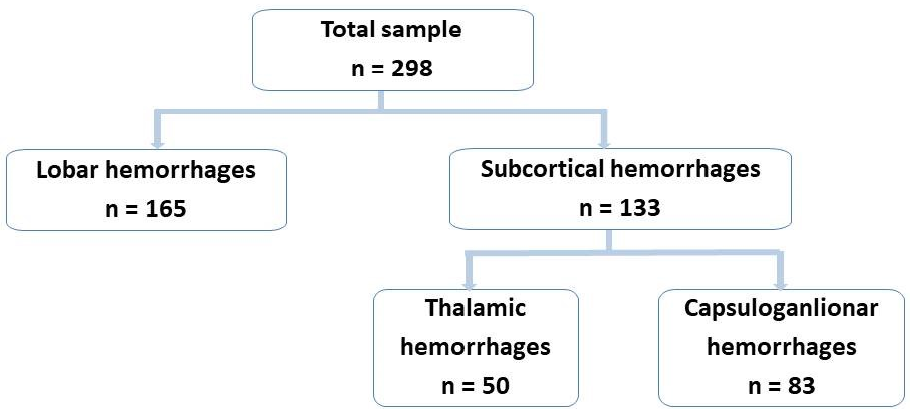
Figure 3. Topography of the spontaneous intracerebral hemorrhages included in the study. The percentage of women was higher in lobar hemorrhages (53.9%), while males were more frequent in subcortical hemorrhages (61.7%). The demographic characteristics of the patients included in the study are shown in Table 2. Table 2. Demographic data of patients with spontaneous acute lobar cerebral hemorrhages versus deep subcortical intracerebral hemorrhages.